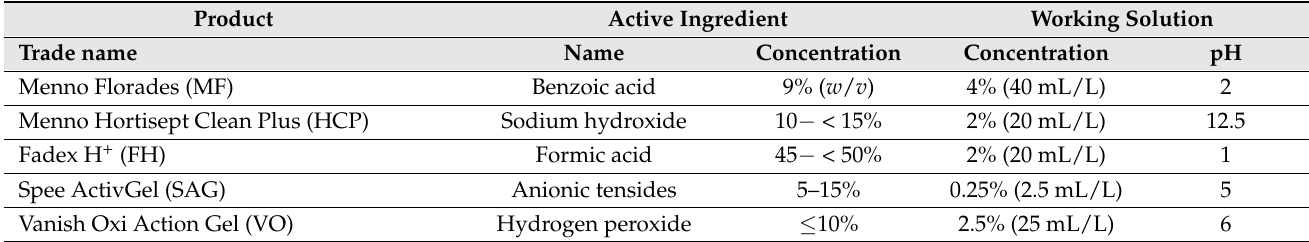
Table 1. List of products, their active ingredients, and the tested concentration of the working solution for cleaning artificial Tomato brown rugose fruit virus (ToBRFV)-contaminated